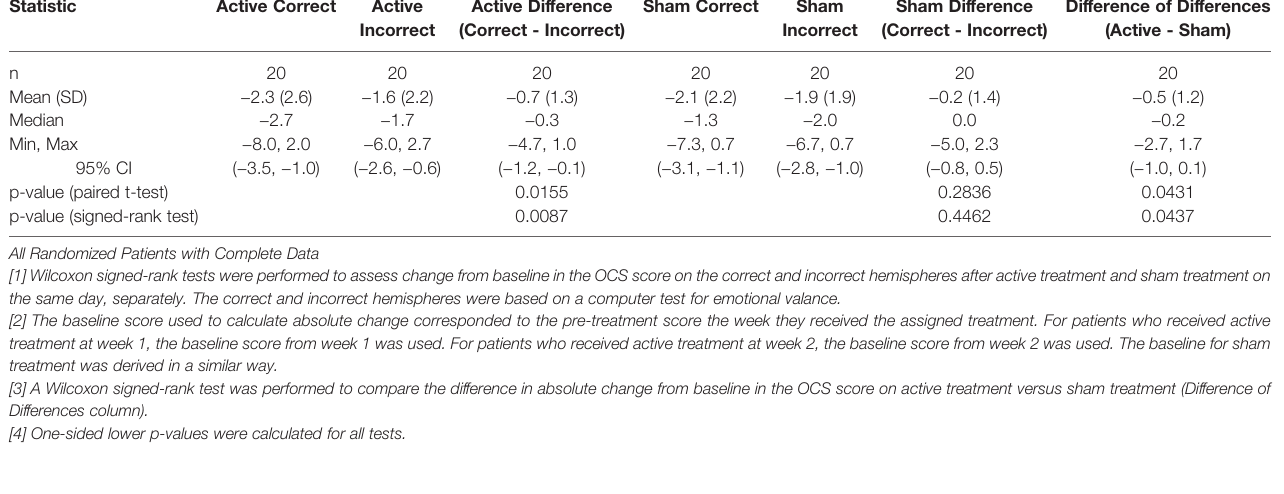
TABLE 8 | Comparison of Absolute Change in Mean OCS Scores Between Active and Sham Treatment by Correct vs. Incorrect Hemisphere.